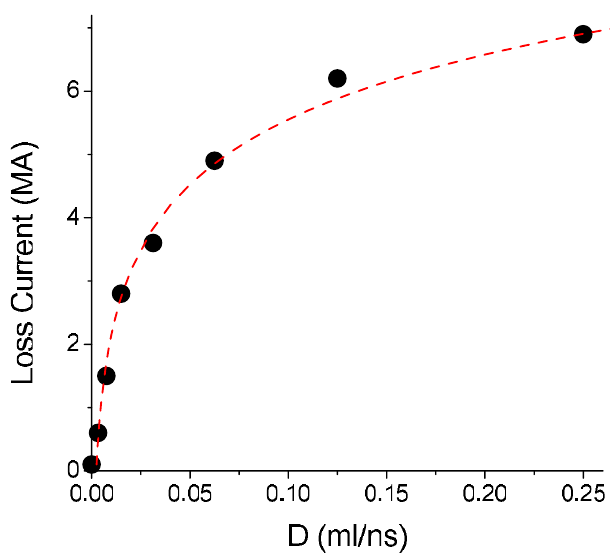
nulls.FIG. 4. (Color) Loss current values (circles) plotted as a function of cathode plasma desorption rate D from the PIC simulations. The dashed line is a logarithmic function fit discussed in the